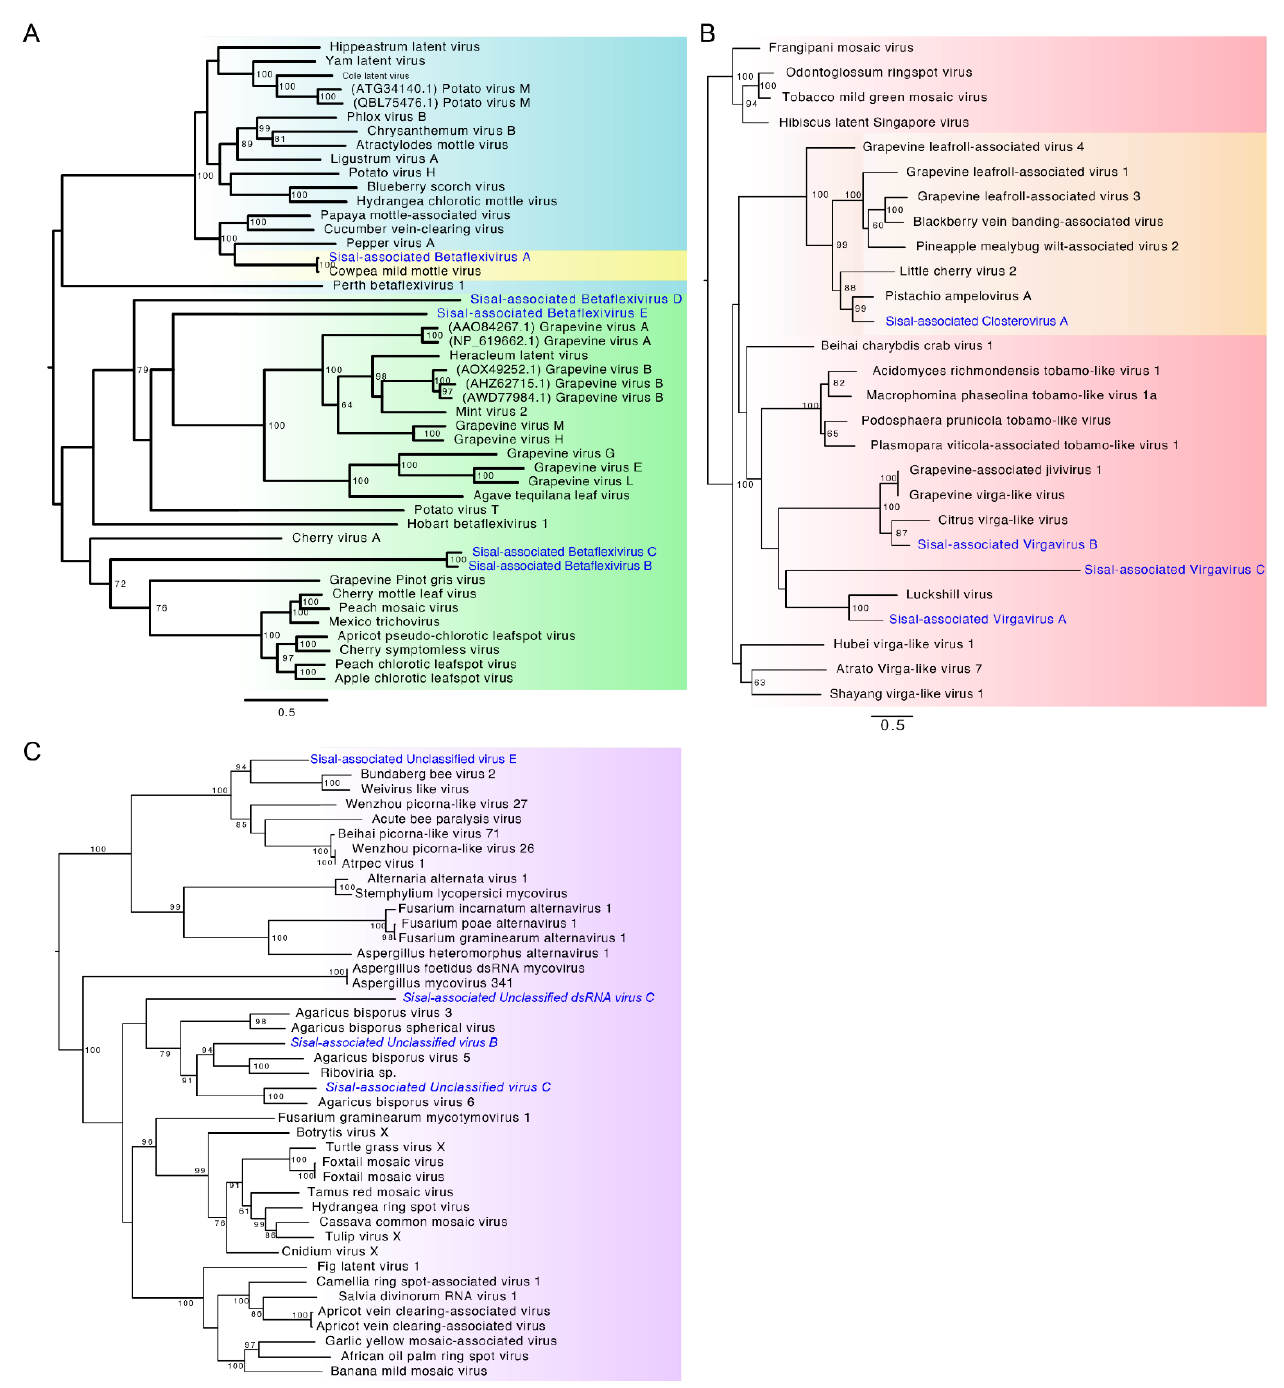
Figure 3. Phylogenetic analysis of high-confidence viral sequences identified in Agave species. Phylogenetic trees contain 13 selected species, highlighted in blue. ( A ) Family Betaflexiviridae. In blue; Carlavirus. In green; Trinivirinae. In yellow; unclassified Betaflexivirus. ( B ) +ssRNA (positive sense, single-stranded RNA), in red. In orange; Ampelovirus. ( C ) Riboviria (in violet). Node support values were determined using 1000 pseudoreplicates where values over 60% of confidence are shown.